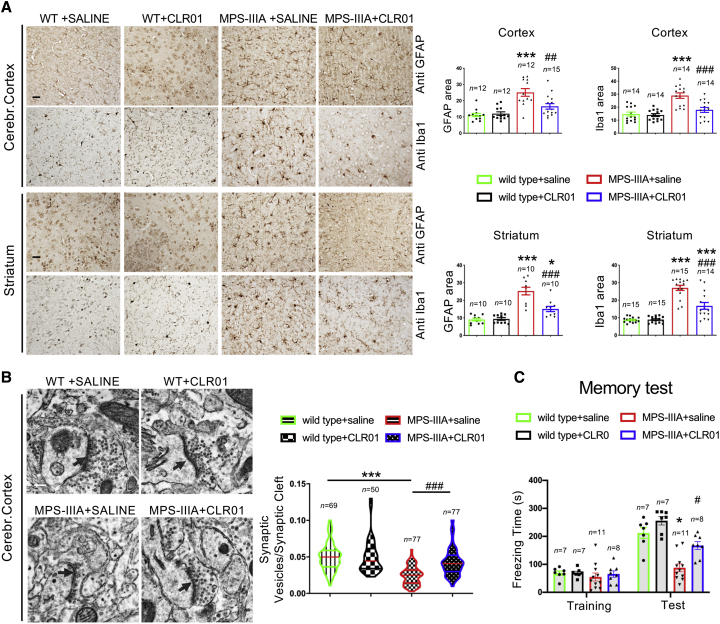
CLR01 Treatment Ameliorates Neuropathological Signs in MPS-IIIA Mice(A) Immunohistochemistry with anti-GFAP and anti-Iba-1 antibodies was performed on sagittal both cortical and striatal brain sections derived from mice belonging to the four experimental groups at 9 months of age. Images show a reduction of both inflammatory markers in MPS-IIIA mice upon CLR01 treatment. GFAP and Iba1 immunoreactivity were quantified in 10–15 different fields. Three mice for each experimental group were analyzed. *p < 0.05 versus WT + saline; ***p < 0.001 versus WT + saline; #p < 0.05, ##p < 0.01, ###p < 0.001 versus MPS-IIIA + saline; one-way ANOVA with Bonferroni’s multiple comparison test. Data are represented as means ± SEM. (B) TEM analysis of synaptic-vesicle number was performed in the cerebral cortex of mice belonging to the four experimental groups at 9 months of age. The graphic representation shows the synaptic vesicles/synaptic cleft length ratio for at least 50 synapses derived from 3 mice for each experimental group. The arrows indicate the synaptic cleft. ***p < 0.001 versus WT + saline; ###p < 0.001 versus MPS-IIIA + saline, one-way ANOVA analysis with Bonferroni’s multiple comparison test. (C) Memory function was tested in mice at 9 months of age using the contextual fear-conditioning task. Three different cohorts of injected animals were used. Graphical representation of contextual fear-conditioning results (freezing time during training and test) show that memory deficits in control MPS-IIIA mice (reduced freezing time) were rescued by CLR01 treatment. 7–11 male mice in each group were tested. Repeated-measures ANOVA: Genotype F1,29 = 23.046; p < 0.0001; Treatment F1,29 = 7.862; p = 0.0089; Freezing F1,29 = 241.926; p < 0.0001; Freezing × Genotype F1,29 = 42.580; p < 0.0001; Freezing × Treatment F1,29 = 14.086; p = 0.0008. *p < 0.05 versus WT; #p < 0.05 versus MPS-IIIA, Duncan post hoc test. WT saline (n = 7), WT + CLR01 (n = 7), MPS-IIIA saline (n = 11), MPS-IIIA + CLR01 (n = 8). Data are represented as means ± SEM. Scale bars represent 25 μm (A) and 0.2 μm (B).